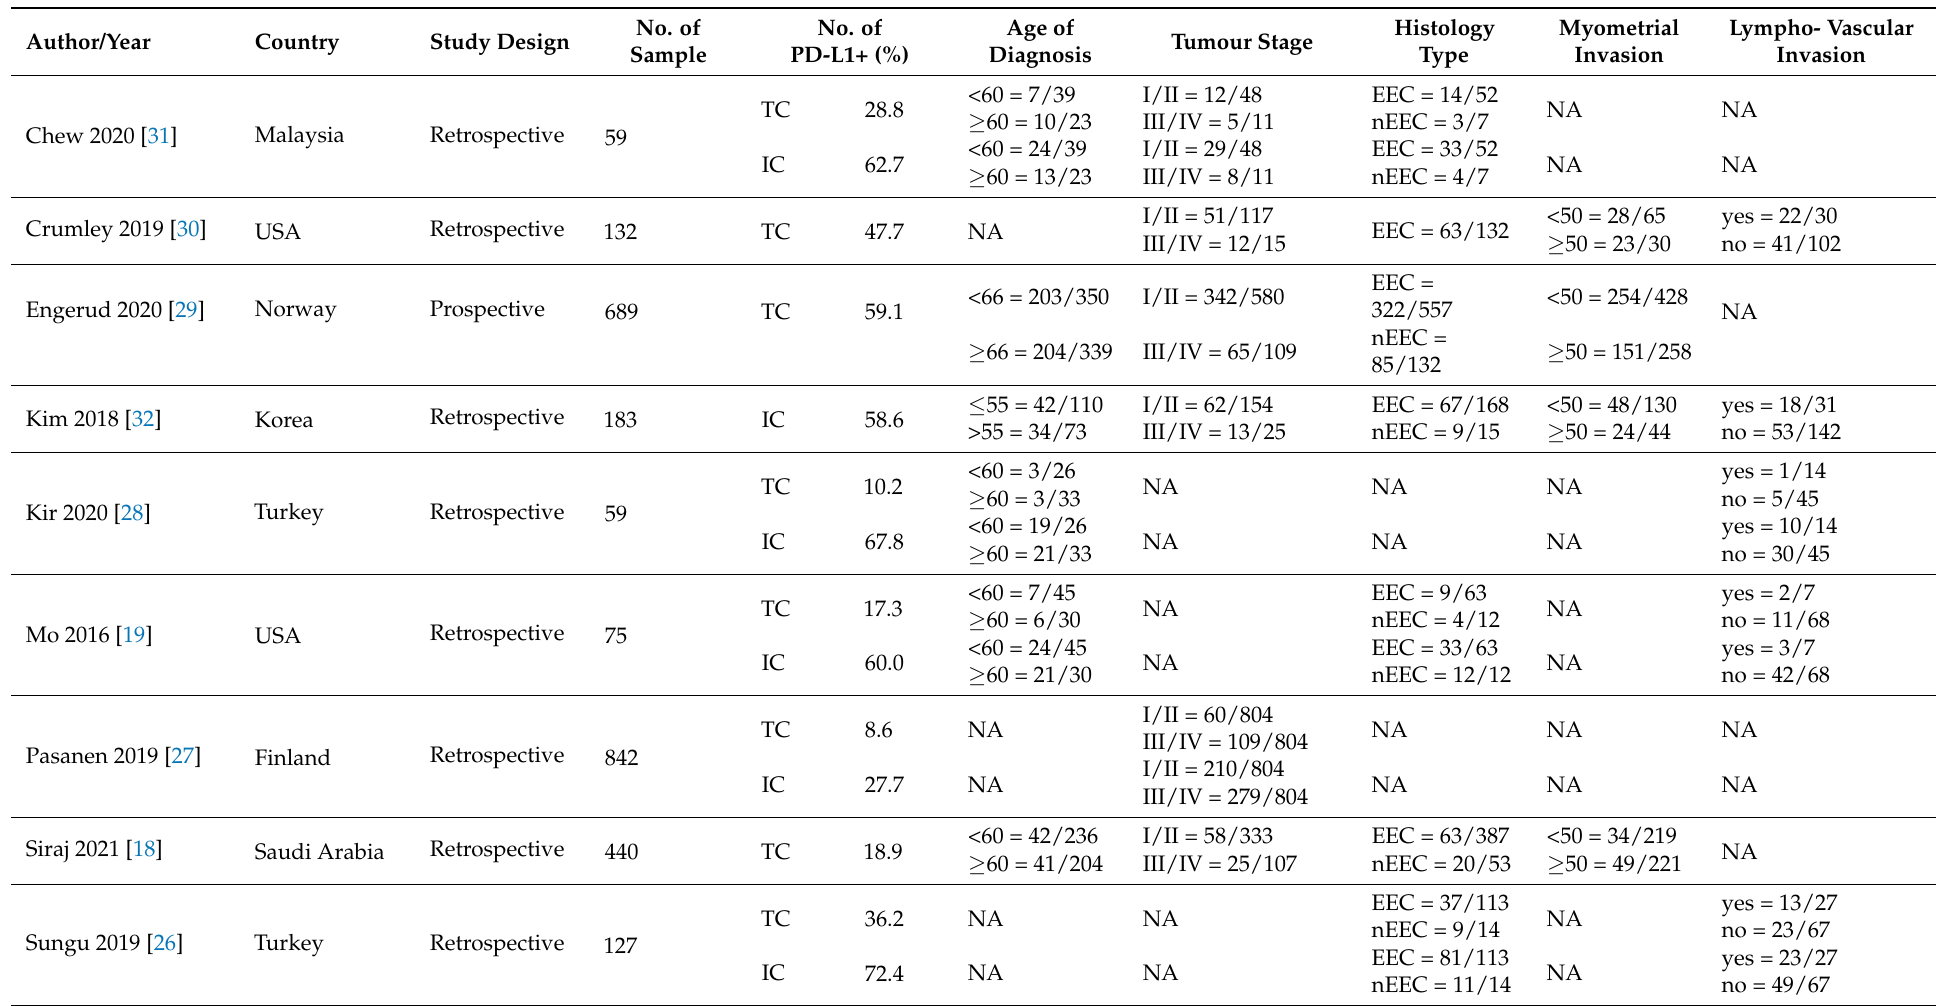
Table 2. A summary of 12 studies that included cases of PD-L1 positive expression with clinicopathological factors among patients with endometrial